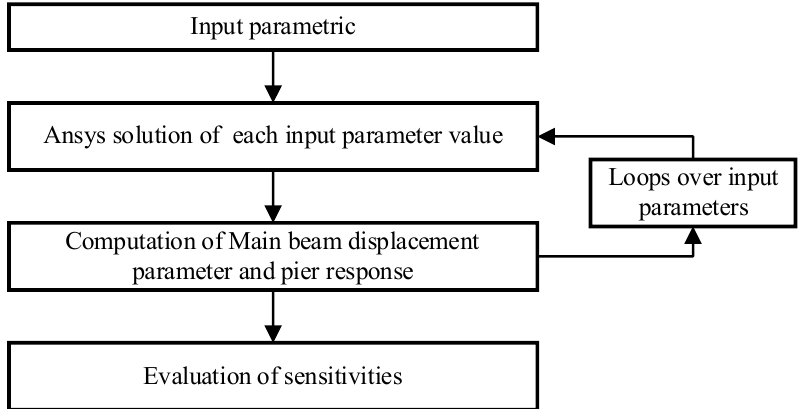
Figure 17. The flow-process diagram of filtering the sensitive parameters.